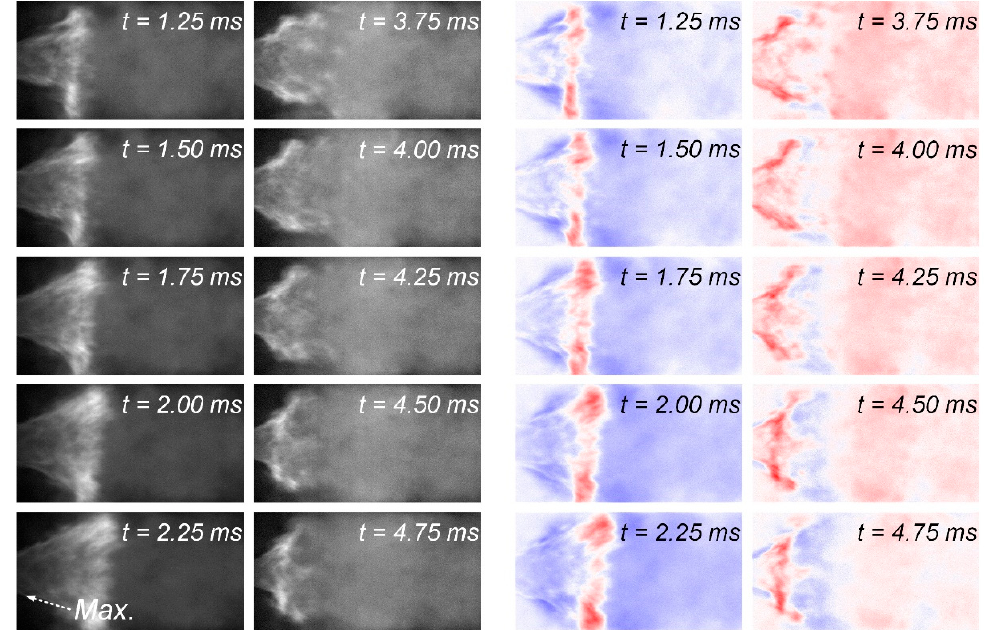
Figure 16. Representative instantaneous flame images ( left ) and their oscillating components ( right ) using C 2 H 4 at L C = 1195 mm, SN = 0.46, u = 15 m/s, and ϕ =